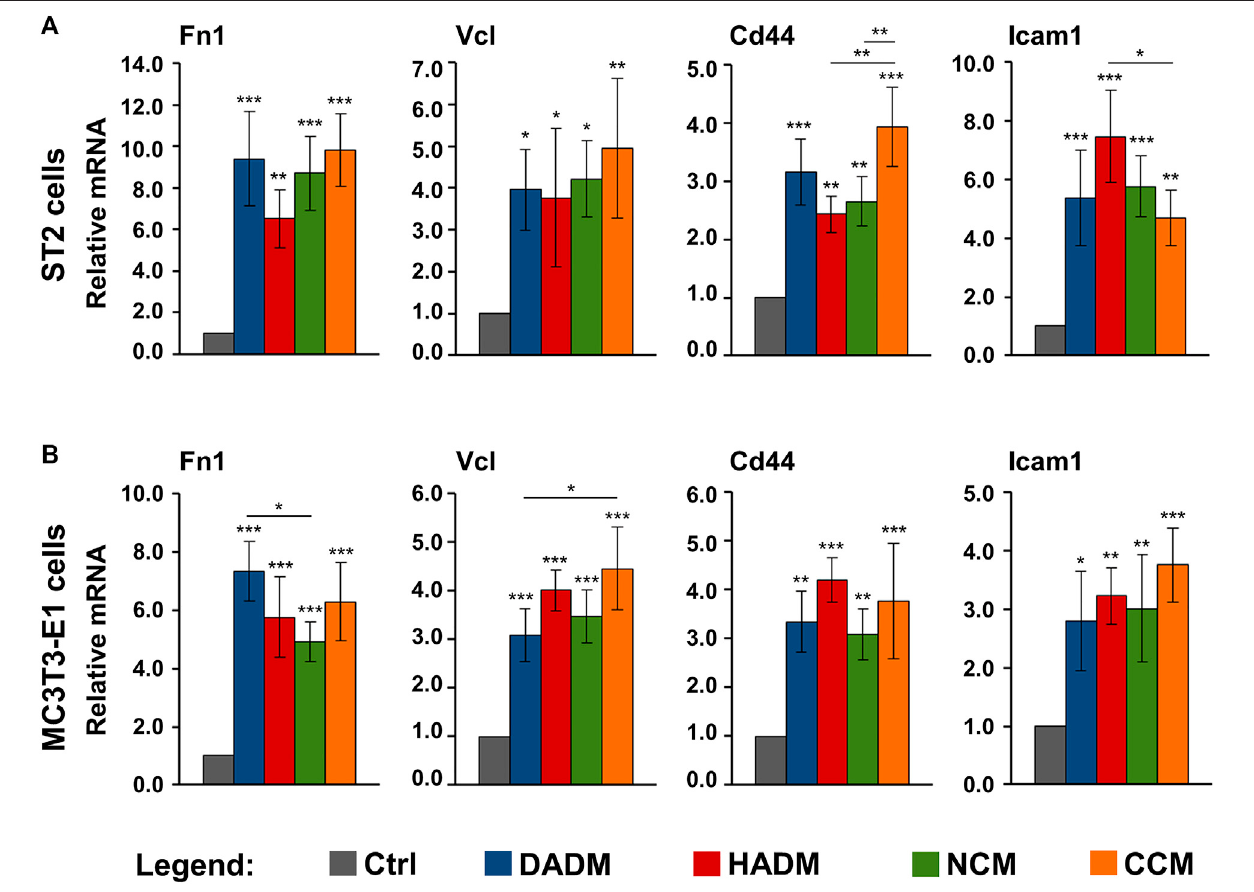
FIGURE 4 | Increased expression of adhesive marker genes in osteoprogenitor cells grown on four different collagen-based matrices. ST2 (A) and MC3T3-E1 (B) cells were cultured in the absence of a matrix (Ctrl) or on DADM, HADM, NCM, or CCM collagen-based matrices for 10 h followed by an extensive wash for complete removalofnonadherentcells.Subsequently,totalcellularRNAwasisolated,puri fi ed,andanalyzed fortheexpressionofFn1,Vcl,Cd44,andIcam1adhesivemarkersby qRT-PCR. Values normalized to Gapdh are expressed relative to the values of control cells. Data represent means ± SD from four independent experiments performed with each of the two cell lines. Signi fi cant differences to the respective controls unless otherwise indicated, *** p < 0.001, ** p < 0.01, * p < 0.05.